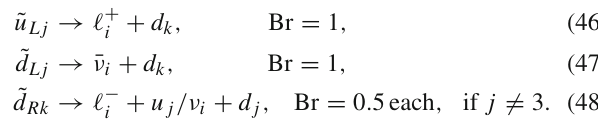
Table 11 Lower mass bounds on supersymmetric particles as the LSP decaying directly via an RPV operator. These are all not (cid:6) (cid:5) R scenarios. The bounds marked by an asterisk ∗ are re-interpreted lep- Particle Lower bound (GeV) RPV coupling Simpl.